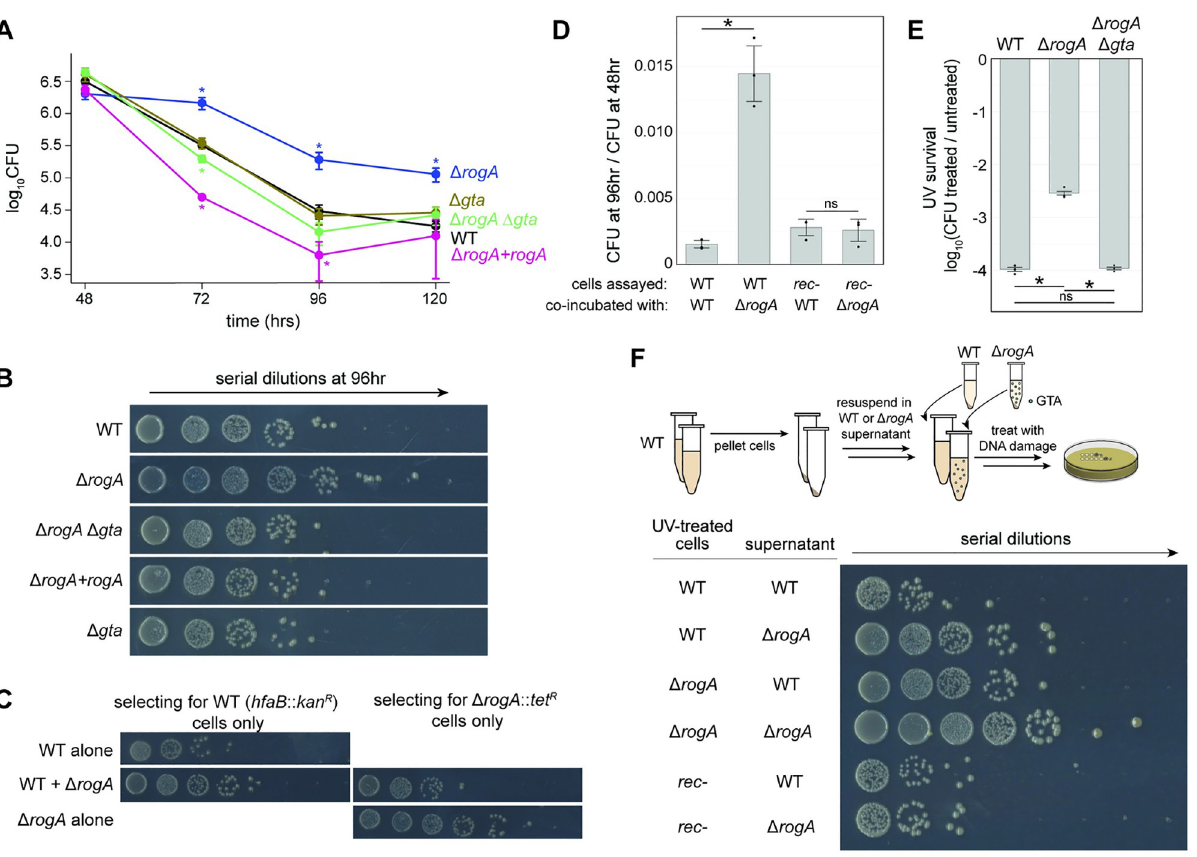
Fig 5. GTAs provide a long-term survival benefit. (A) Survival of various strains in PYE over several days ( n � 3, error bars indicate SD). � = p -value < 0.05 comparing data of same time point to wild type. Data are available in S1 Data. (B) Representative images of cell survival after 96 h in PYE. (C) Survival of wild-type ( hfaB :: kanR ) or Δ rogA :: tet R cells when grown together or alone. Cells were enumerated on plates containing either kanamycin or tetracycline to select for either wild-type or Δ rogA cells. (D) Survival of the wild type ( hfaB :: kan R ) or the recombination-deficient rec526 strain in combination with either wild-type or Δ rogA cells in stationary phase ( n = 3, error bars indicate SD). � = p -value < 0.05 between indicated data. ns = not significant. Data are available in S1 Data. (E) Survival of different strains in response to high levels of UV during stationary phase. Survival rates are plotted as the (CFU after treatment)/(CFU before treatment) ( n = 3, error bars indicate SD). � = p -value < 0.05 between indicated data. ns = not significant. Data are available in S1 Data. (F) Schematic for treating cells with UV after providing supernatants from different cultures. Survival of different strains with supernatant from either wild-type or Δ rogA stationary phase cultures. CFU, colony-forming unit; GTA, gene transfer